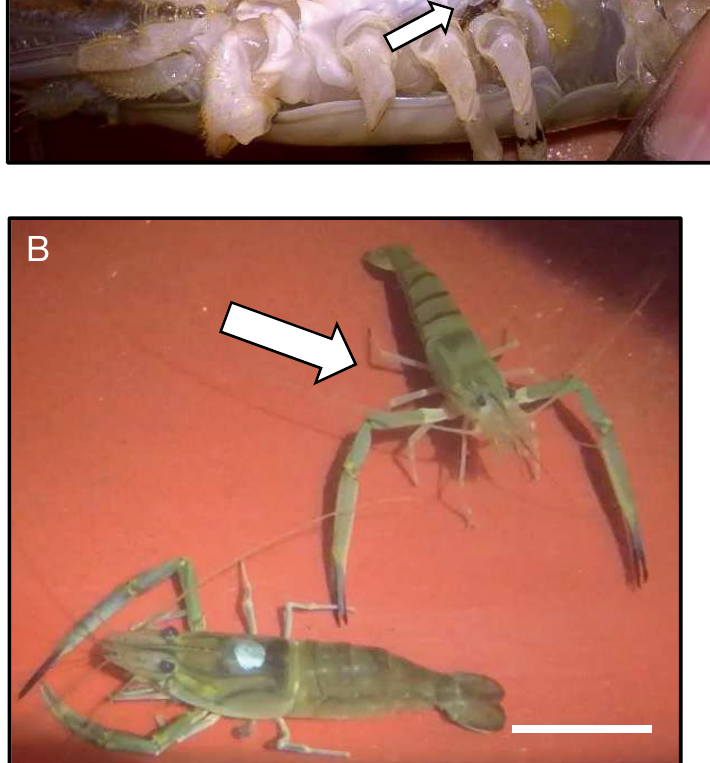
Fig. 1. Macrobrachium vollenhovenii detector male. (A) Ventral view. The visible implant elastomer can be seen as small, dark patches at the base of the fifth walking legs (white arrows). Bar represents 15 mm. (B) Dorsal view of the detector male (ar- row) guarding a marked female in the artificial insemination tank. Bar represents 40